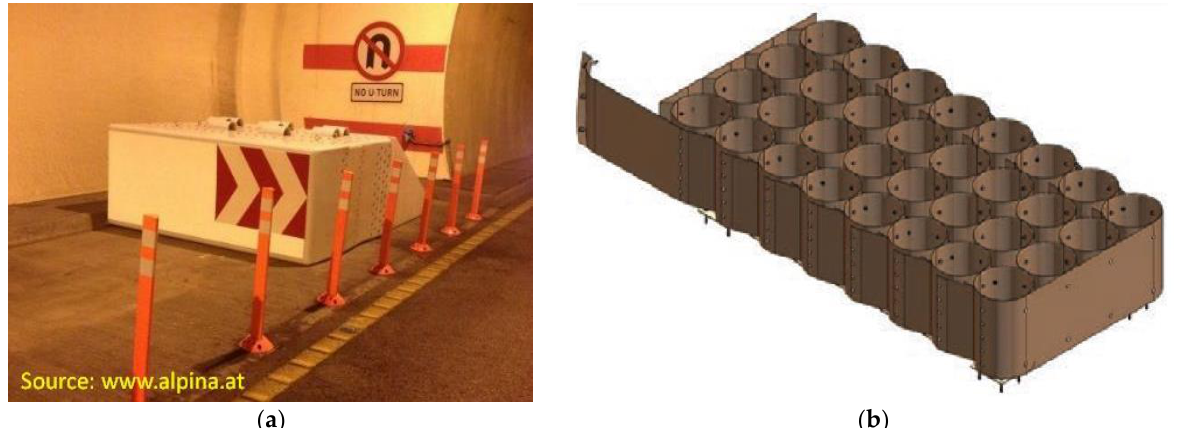
Figure 2. Crash cushion positioned in front of the end-wall of a lay-by ( a ) [42] and geometrical model a crash cushion ( b ) [2,28].